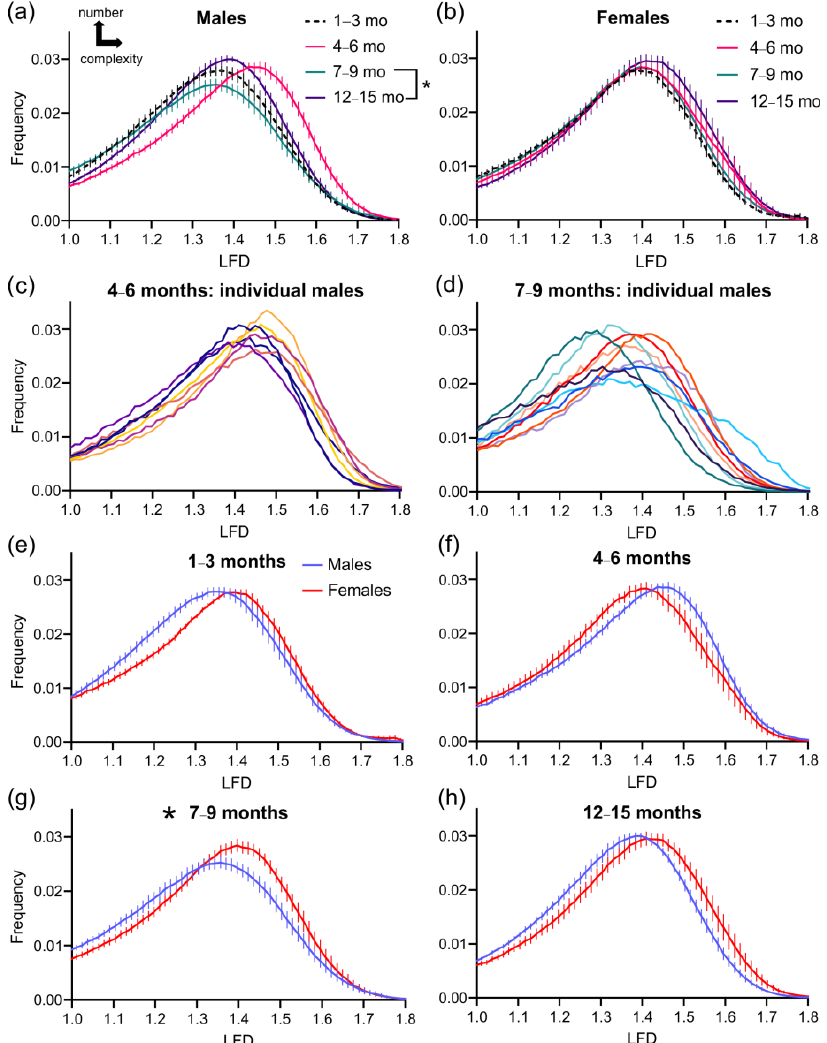
Figure 4. Local fractal dimension (LFD) histograms for vascular complexity. The cortical vessel complexity in aging 3xTg-AD mice illustrates robust differences in males ( a ), but not in females ( b ). Individual LFD histograms in male mice at 4 – 6 months ( c ) and at 7 – 9 months of age ( d ) demonstrate increasing variability at later ages. Each line in ( c ) and ( d ) represents an individual mouse. Comparison of LFD histograms between males and females are shown for 1 – 3 months ( e ), 4 – 6 months ( f ), 7 – 9 months ( g ), and 12 – 15 months ( h ) groups, illustrating the dynamic alterations with time. At 7 – 9 months of age, there was a significant difference between males and females. * p < 0.05 for the skewness and kurtosis values (see Figure 5). Data shown as mean ± SEM.